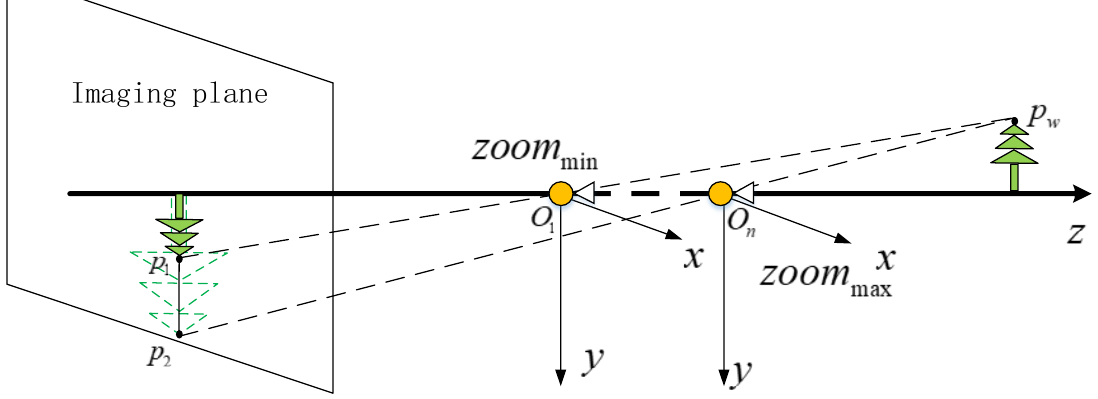
Figure 2. Schematic diagram of focal length variation by zoom. The zoom process of the camera is approximately equivalent to the process of the optical center moving back and forth on the optical axis.